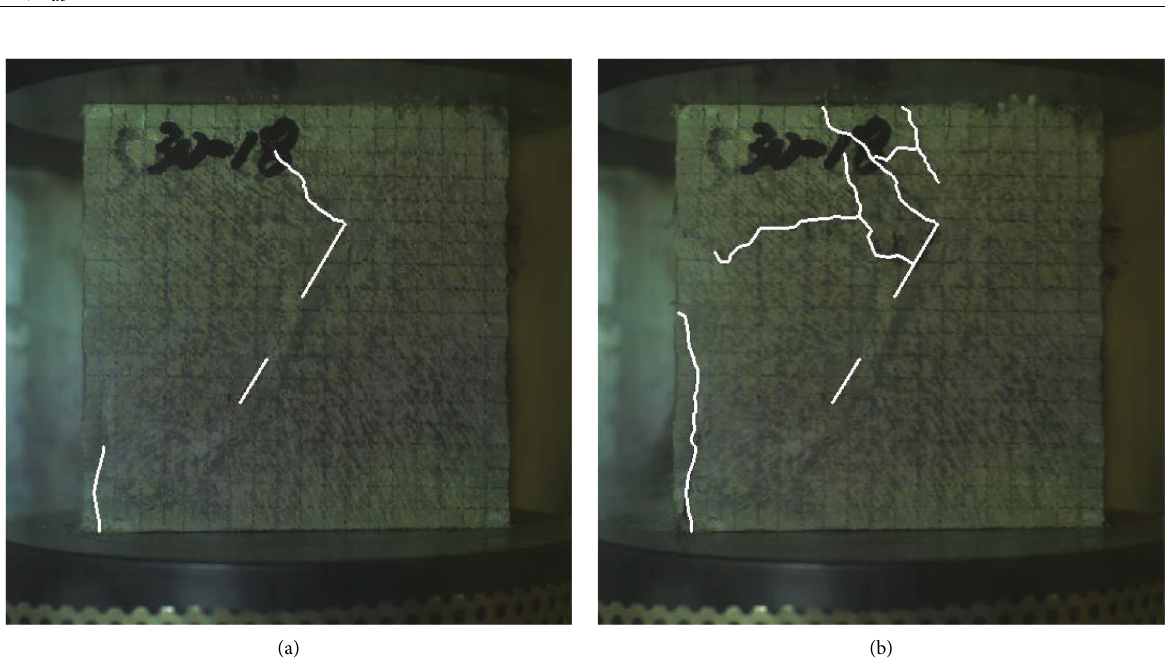
Figure 7: The moment of crack initiation and propagation: (a) the moment of crack initiation and (b) crack